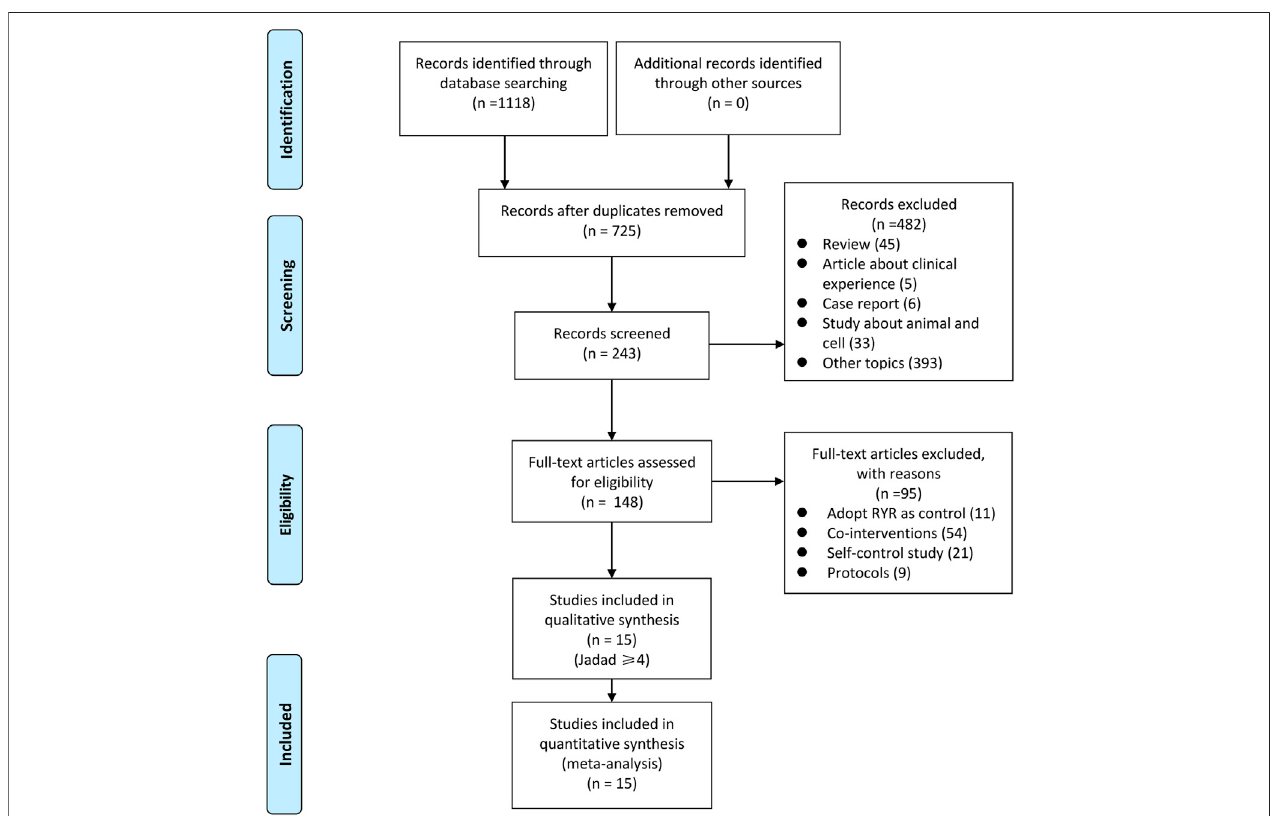
FIGURE 1 | Flowchart of search strategy and study selection, according to the Preferred Reporting Items for Systematic Reviews and Meta-analyses (PRISMA) guidelines.